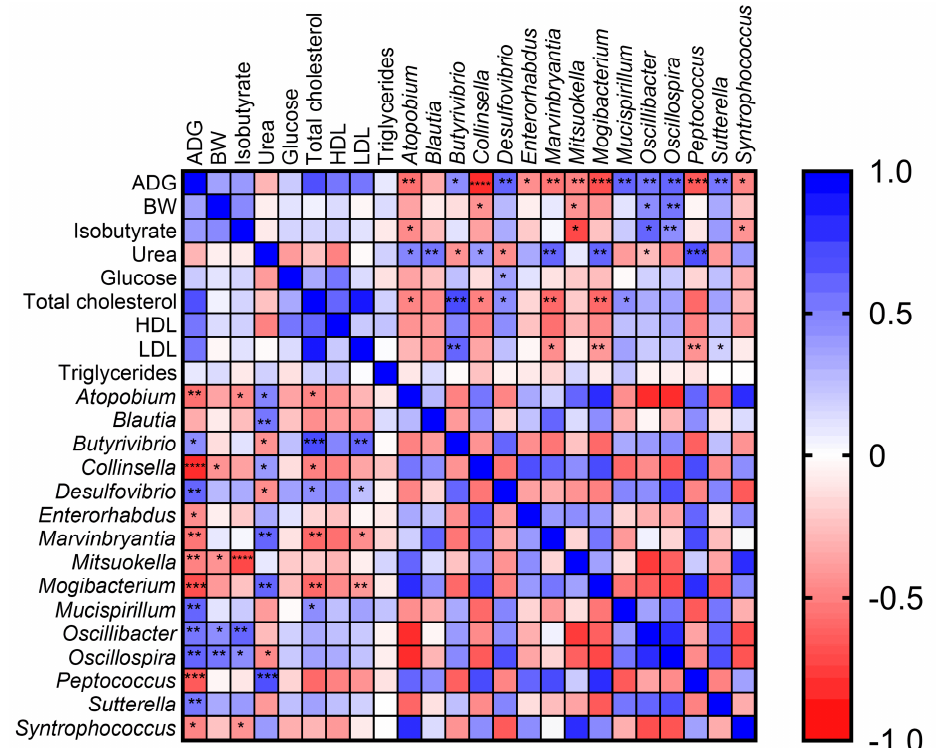
Figure 5. The Spearman correlation heatmap graphically represents the correlation between Average Daily Gain (ADG), Body Weight (BW), isobutyrate, urea, total cholesterol, High-Density Lipoproteins (HDLs), Low-Density Lipoproteins (LDLs) and significant different genera between the two dietary groups. The colors display the r -value. * p ≤ 0.05; ** p ≤ 0.01; *** p ≤ 0.001 and **** p ≤ 0.0001. p value significances were graphically reported only for correlation between the aforementioned parameters and bacterial genus.